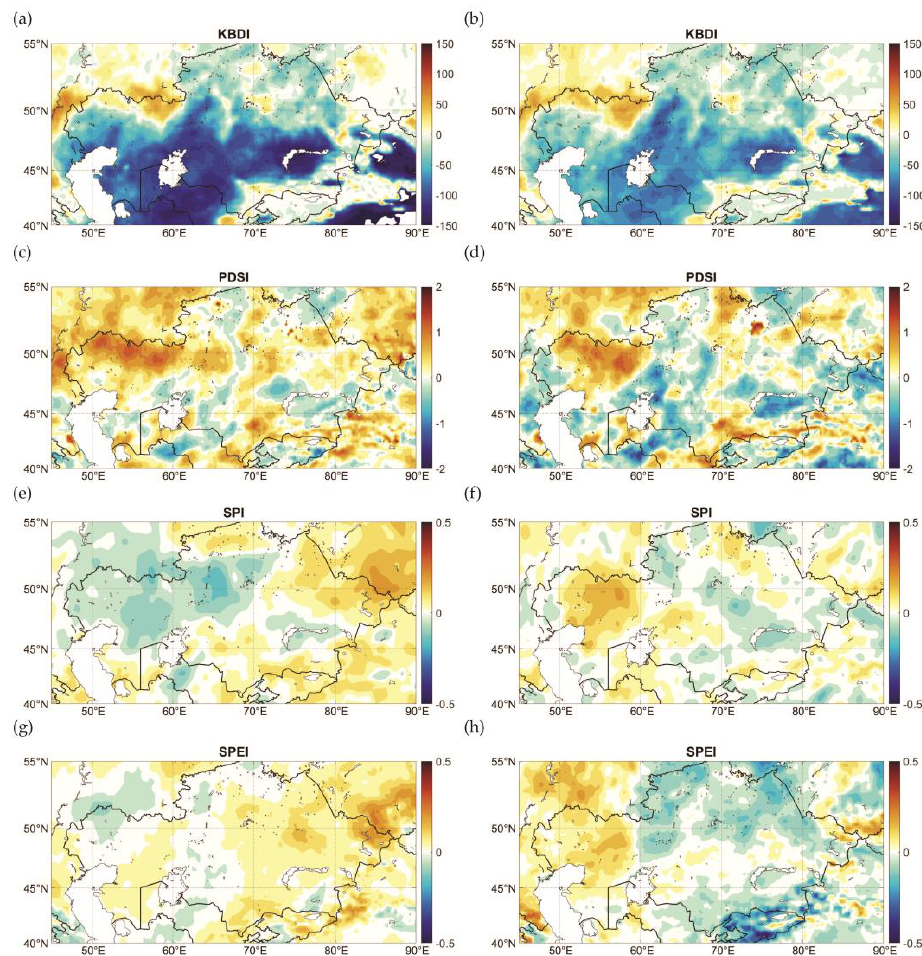
Figure 7. The spatial distribution of the differences in mean standard deviation of dryness indices averaged over the periods 2001–2021 and 1979–2000 in the spring (left column) and summer (right column) seasons, ( a , b ) KBDI, ( c , d ) PDSI,( e , f ) SPI, ( g , h ) SPEI.